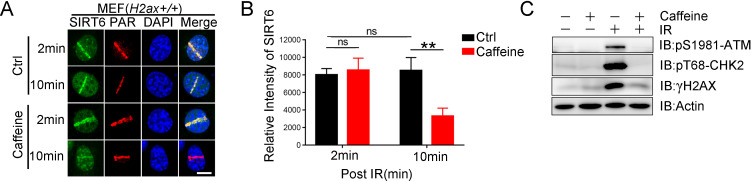
SIRT6 recruitment in cells treated with caffeine.(A) Laser MicroPoint analysis of SIRT6 recruitment in MEFs treated with caffeine (5 mM) 1 hr. Scale bar, 10 μm. (B) The relative intensity was calculated in Fiji (Image J). The data represent the means ± s.e.m., **p<0.01,n.s.: not significant, n = 10. (C) Western blot analysis of γH2AX, pS1981 ATM and pT68 CHK2 levels in MEFs after caffeine treatment.